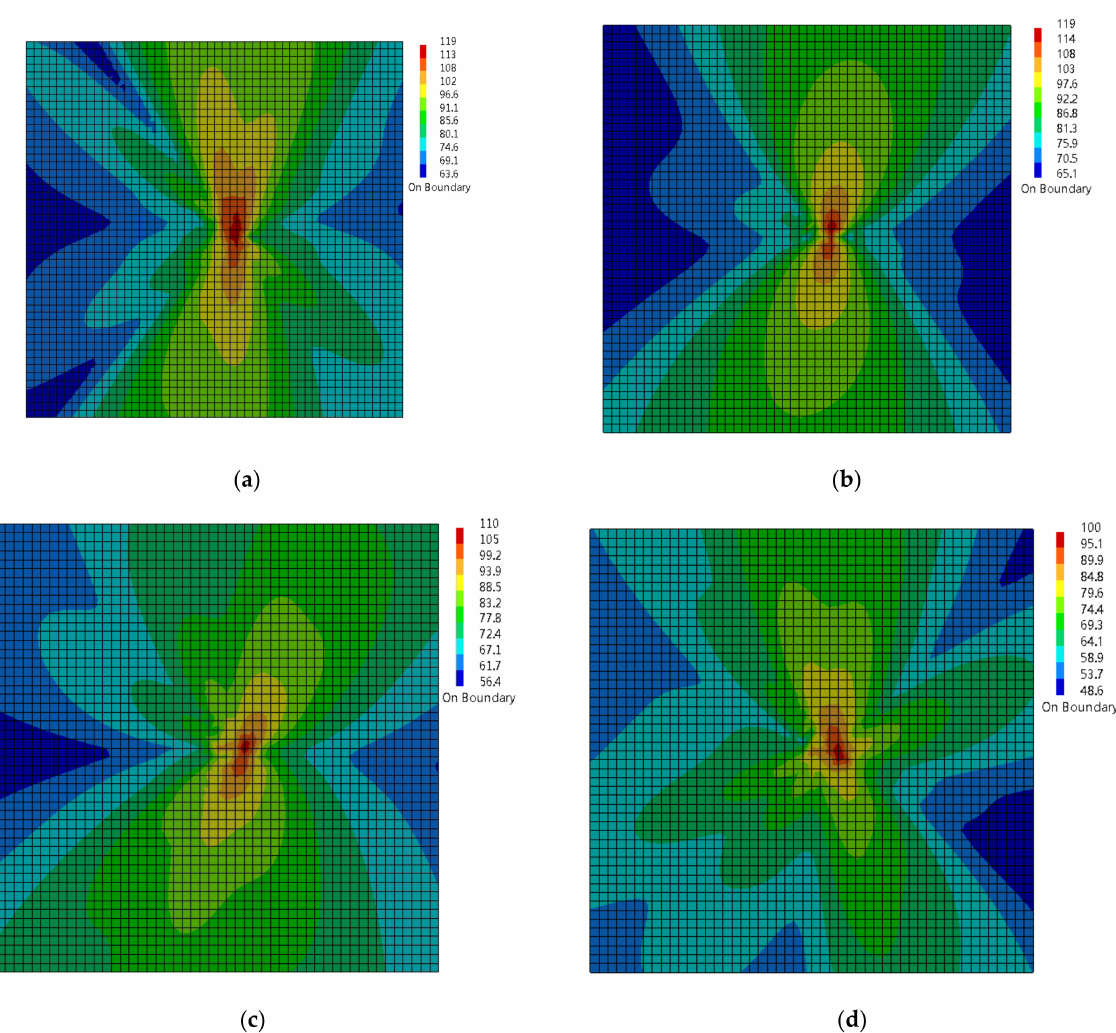
Figure 14. Acoustic radiation field in the yoz plane (1500 Hz): ( a ) no damping; ( b ) damping on the plate; ( c ) damping on the web; ( d ) damping on the ribbed